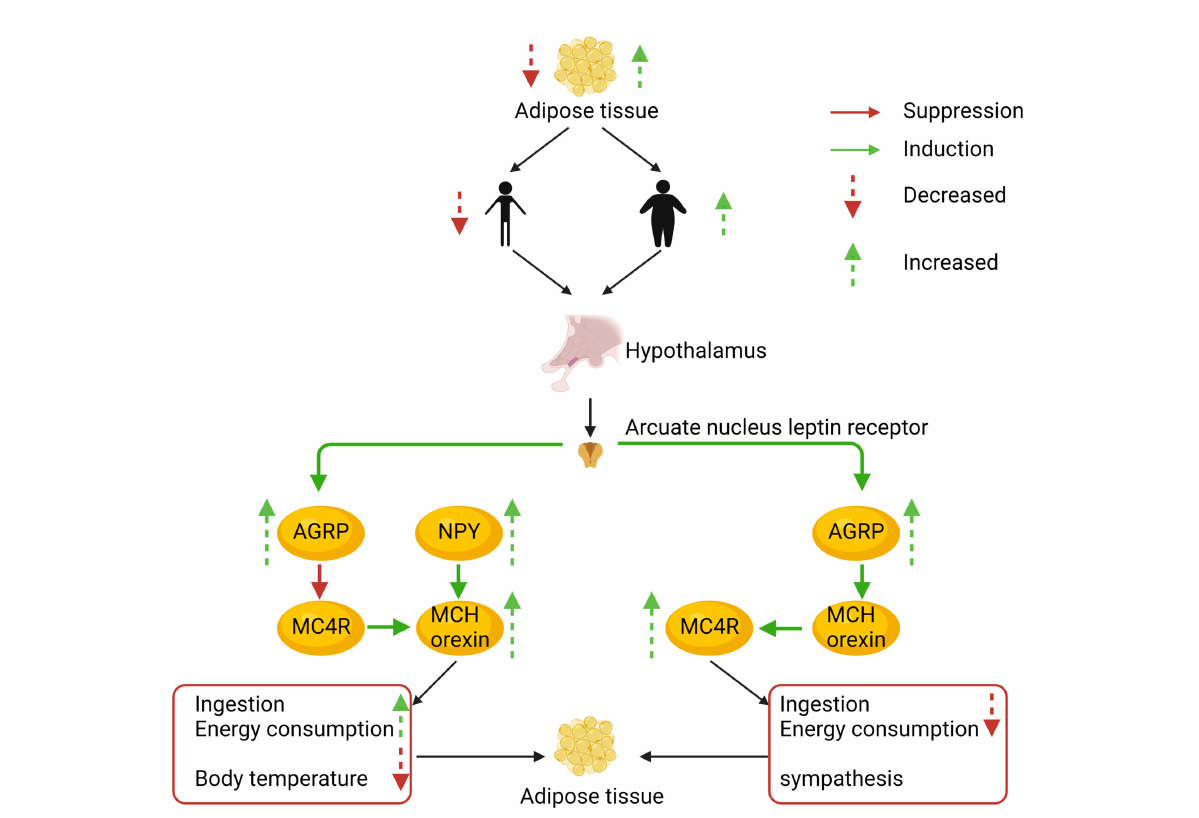
FIGURE 3 The AgRP and melanocortin systems are also involved in body weight regulation. To illustrate the prevalence of obesity, increased research efforts are underway to de fi ne how peripheral hormones and metabolites regulate energy homeostasis. The melanocortin system is crucial for normal energy homeostasis both in rodents and humans. They are regulated by peripheral hormones such as leptin and insulin as well as nutrients such as glucose, amino acids, and fatty